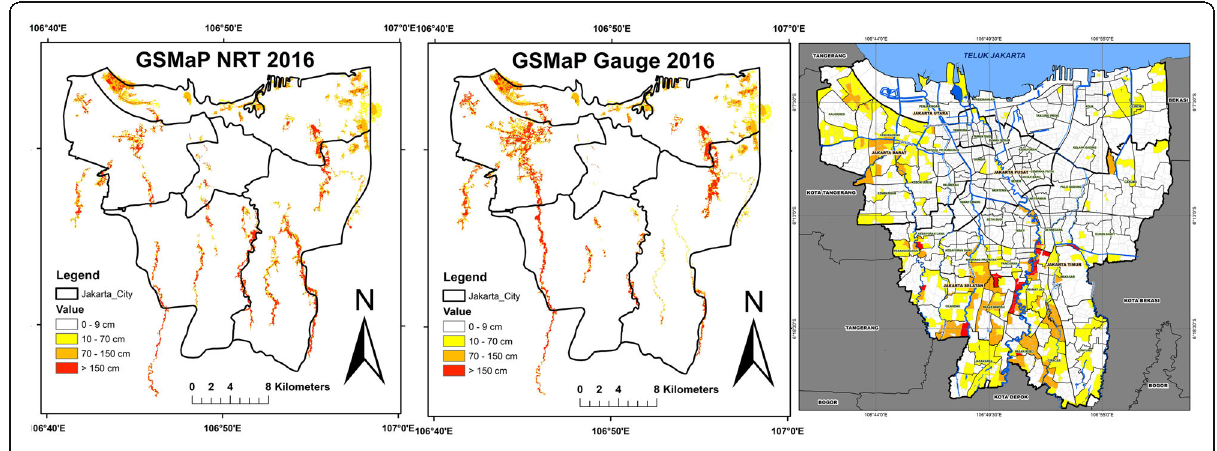
Fig. 13 Flood inundation comparisons for flood event of 2016